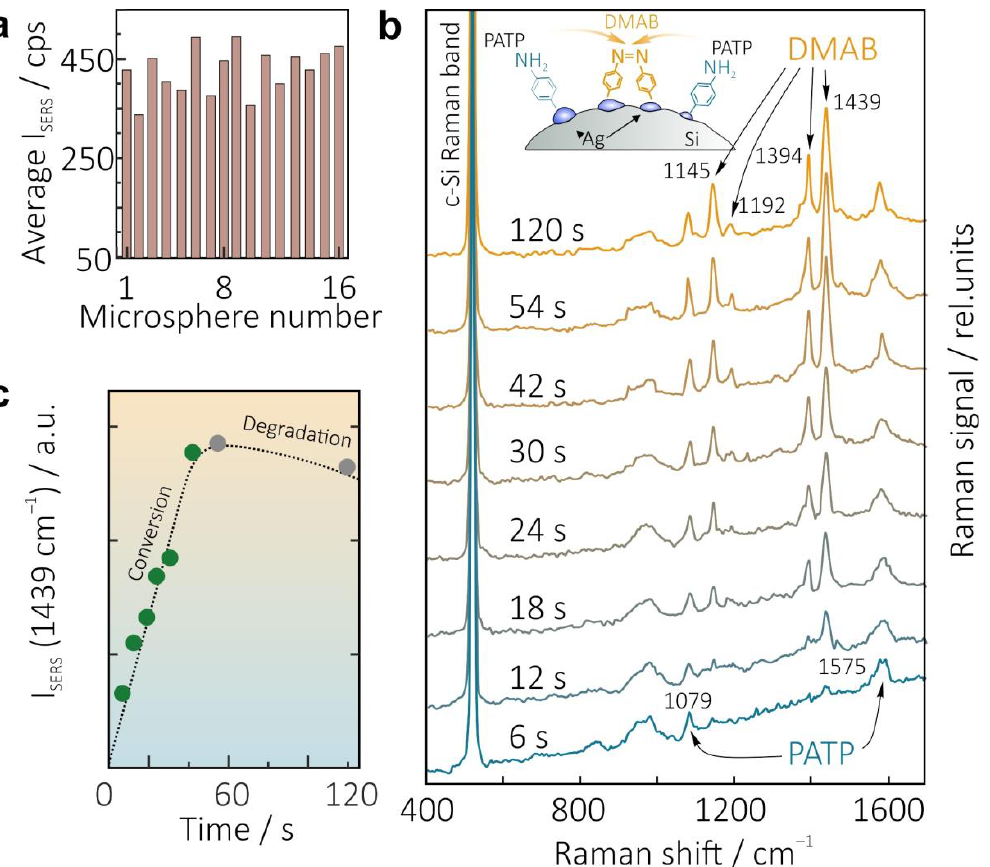
Figure 4. ( a ) R6G SERS yield (intensity of the bands at 612 and 1652 cm −1 ) statistically averaged over measurements from 16 randomly chosen isolated Ag-Si microspheres produced at AgNO 3 concentrations of 5 × 10 −4 M. ( b ) Series of time-resolved SERS spectra of the PATP capping the isolated Ag-Si microsphere. Total laser exposure time ranging from 6 to 120 s is indicated near each spectrum. ( c ) Evolution of the intensity of the characteristics DMAB-related Raman band at 1439 cm −1 as a function of laser exposure time indicating PATP-to-DMAB conversion dynamics.